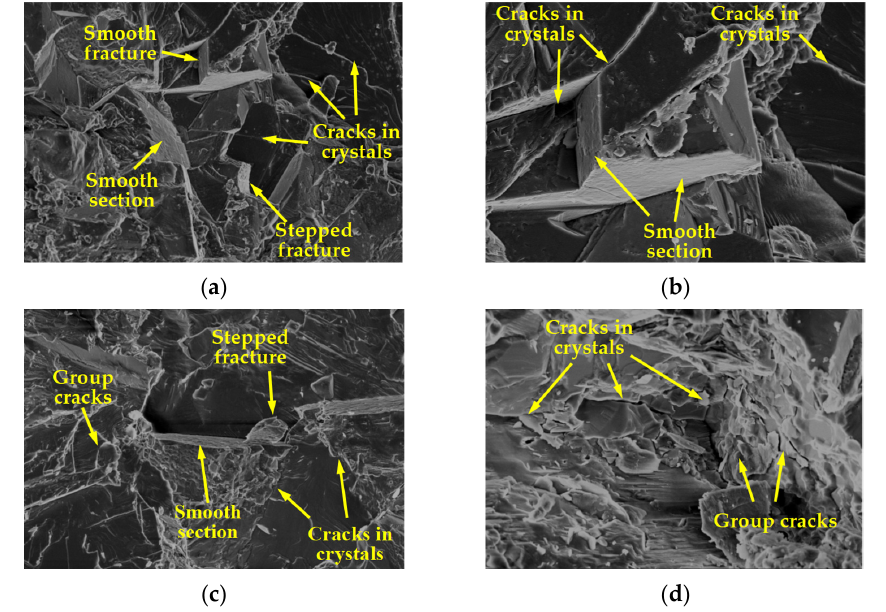
Figure 13. Micro-cracks and fracture characteristics under vertical loading: ( a ) Gray sample (2000×); ( b ) Gray sample (5000×); ( c ) Carbonaceous Sample (2000×); ( d ) Carbonaceous Sample (5000×).